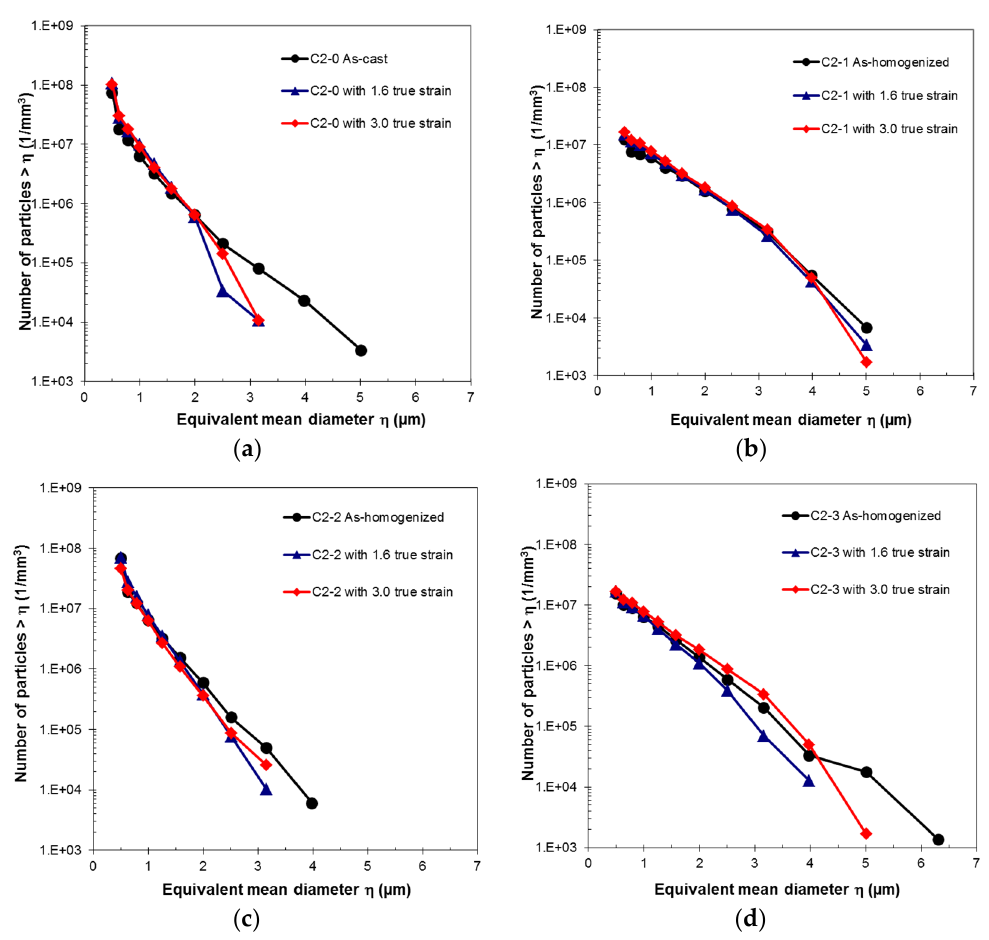
Figure 5. 3D cumulative size distribution of constituent particles for the different material conditions before and after rolling to strains of ε = 1.6 and 3.0: ( a ) C2 ‐ 0; ( b ) C2 ‐ 1; ( c ) C2 ‐ 2; and ( d ) C2 ‐ 3. Table 3. The values of the constituent size distribution parameters, N 0 and L , for the different material conditions ( cf. Figure 5).